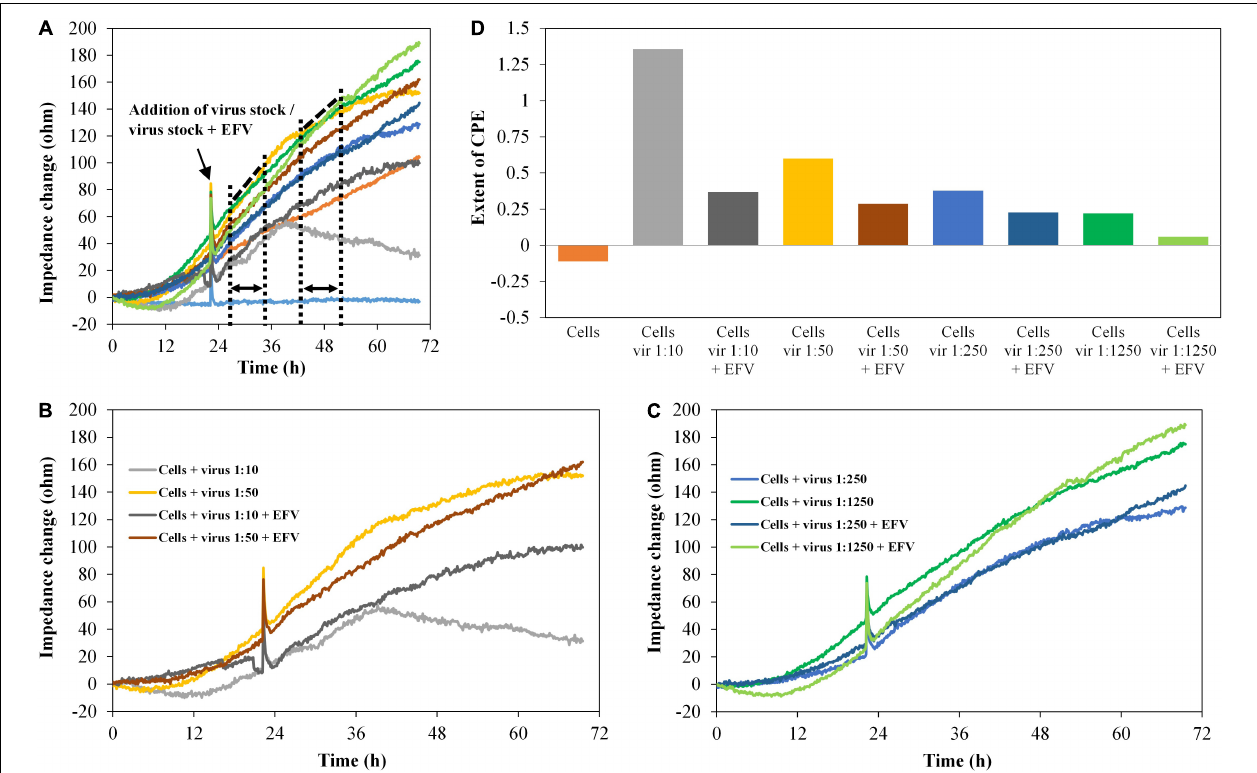
FIGURE 8 | TZM-bl cells, exposed to HIV-1 pseudovirus in different concentrations and antiviral substance efavirenz (2 µ M), n = 2. (A–C) Impedance curves. All curves were set to 0 (cid:127) at t = 0. The slope of medium average was corrected to 0, and all other curves were modified correspondingly. (B,C) show four curves each from (A) . The dashed and dotted lines in (A) illustrate the curve regions used to calculate the extent of the cytopathic effect. (B) shows the samples with high virus concentrations 1:10 and 1:50, without and with EFV, (C) shows the samples with low virus concentrations, 1:250 and 1:1,250, without and with EFV. (D) Extent of CPE on cells with different virus concentrations and without/with antiviral substance. Values were calculated, using the formula described in section “Fabrication of Graphene-Based